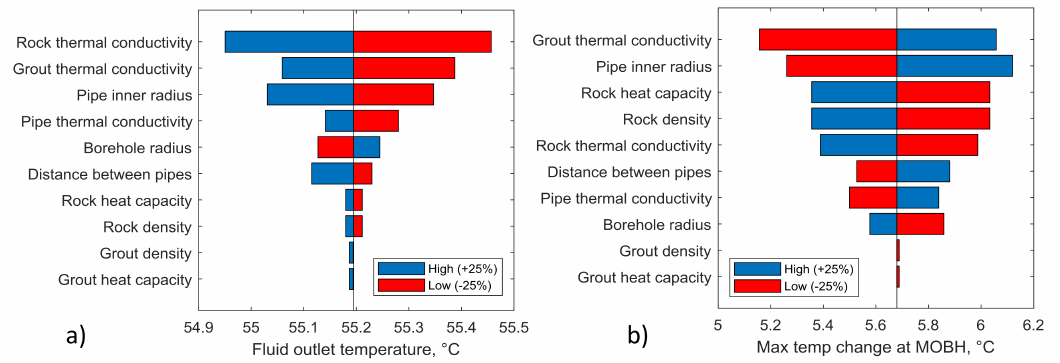
Figure 12. Sensitivity analysis of ( a ) the maximum temperature change at the monitoring borehole; ( b ) the fluid temperature at the BHE outlet after 21 days of heating versus a ± 25% change in the selected model